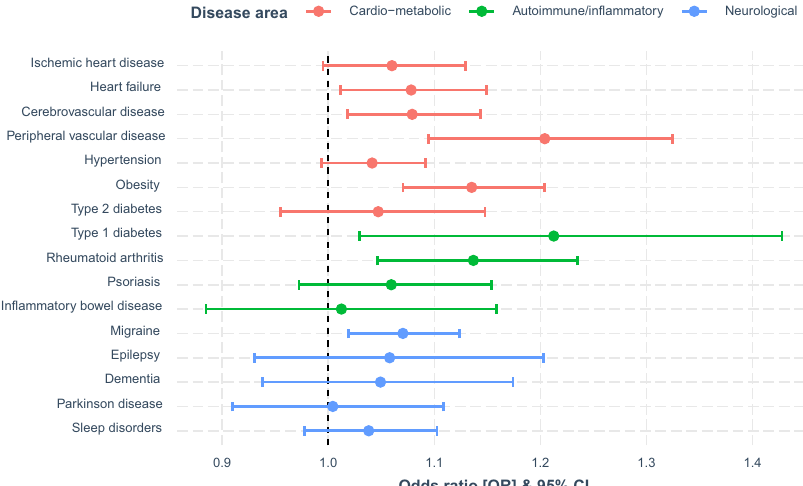
Fig. 1 Associations of ADHD-PRS and somatic health outcomes. Present associations between ADHD-PRS and somatic health outcomes de fi ned by combined register and self-reported data. Associations by each ascertained source separately are presented in Fig. S1. PRS, polygenic risk score. OR, odds ratio. CI, con fi dence interval.